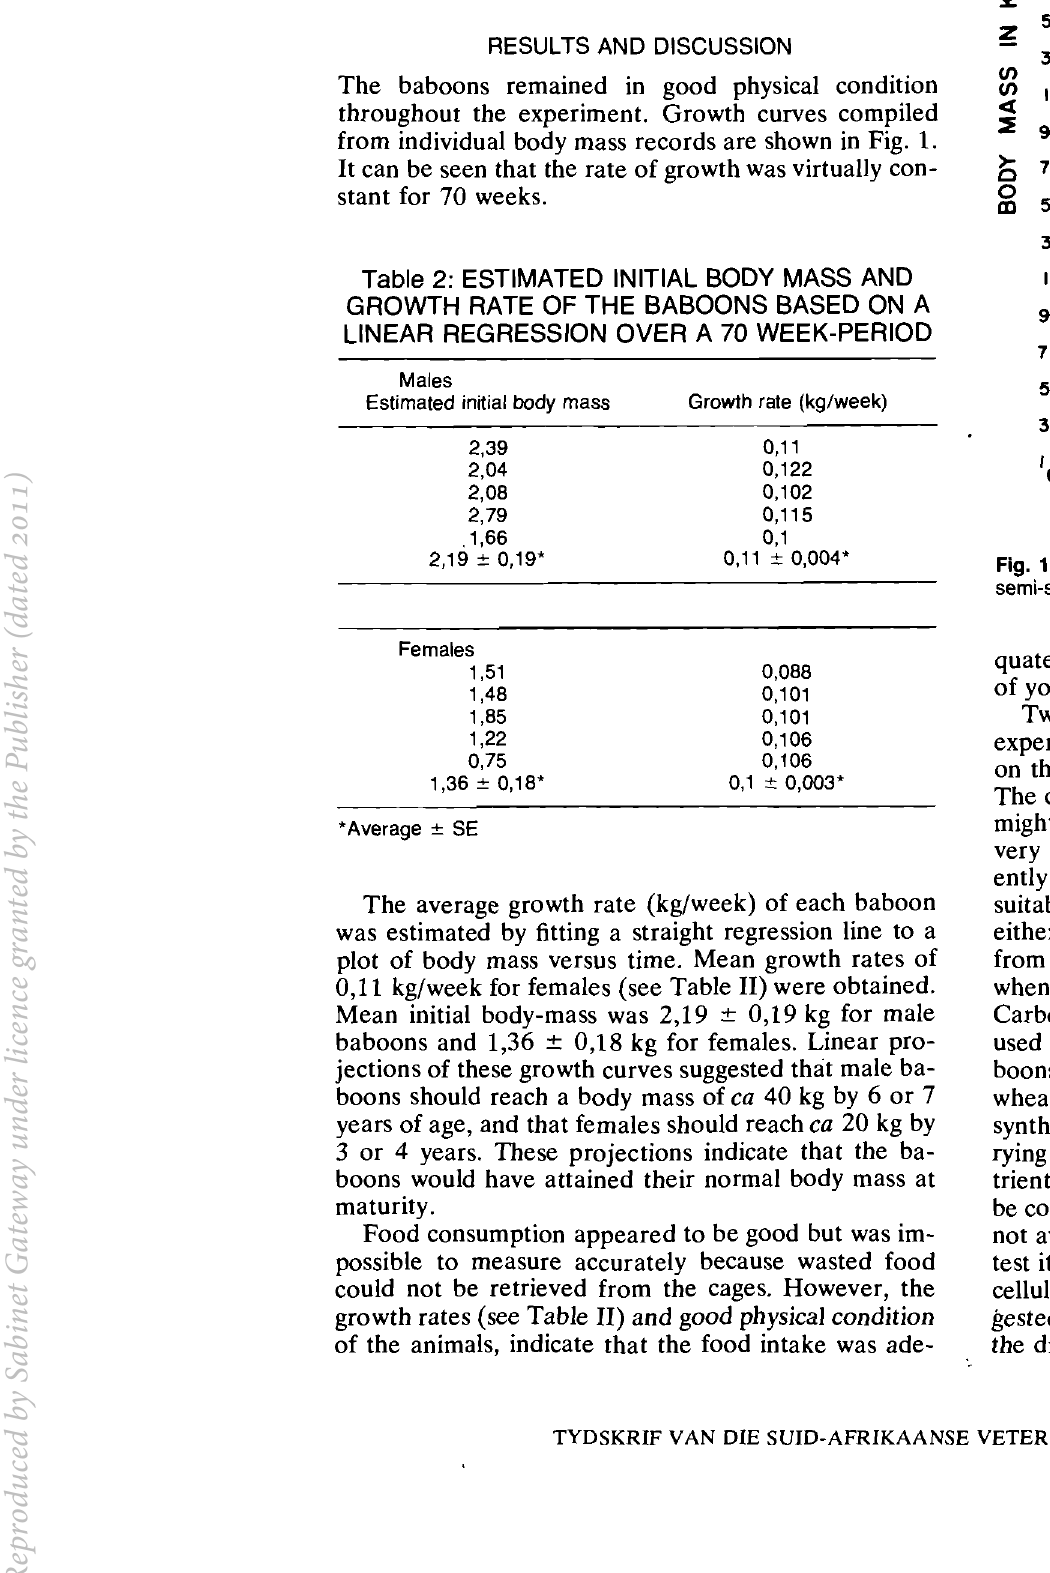
Table 2: ESTIMATED INITIAL BODY MASS AND GROWTH RATE OF THE BABOONS BASED ON A LINEAR REGRESSION OVER A 70 WEEK-PERIOD